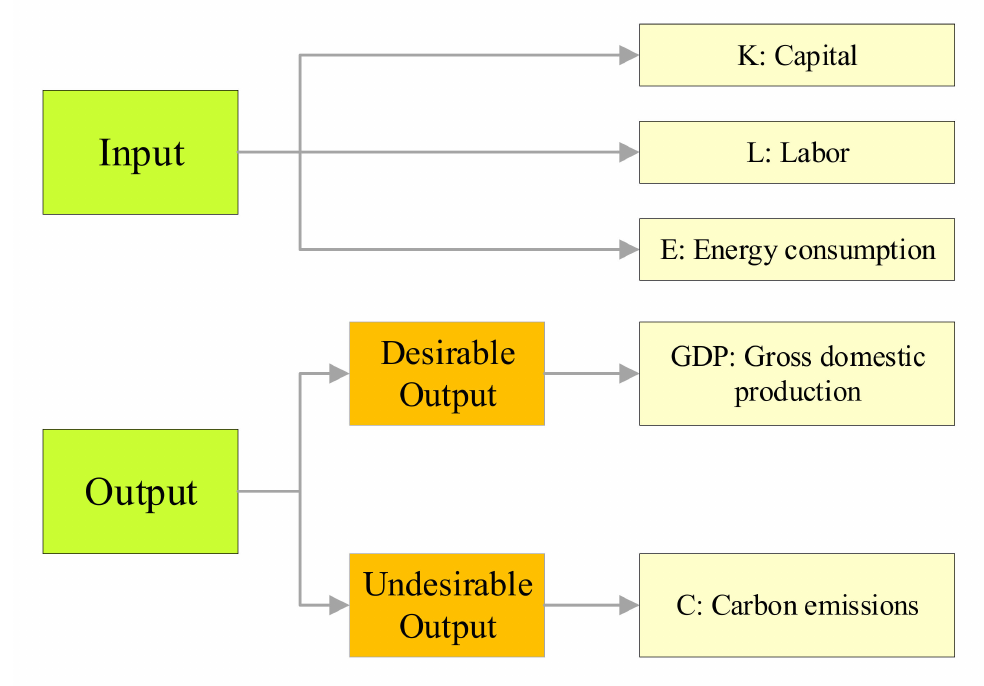
Figure 3. Indicators of carbon emission